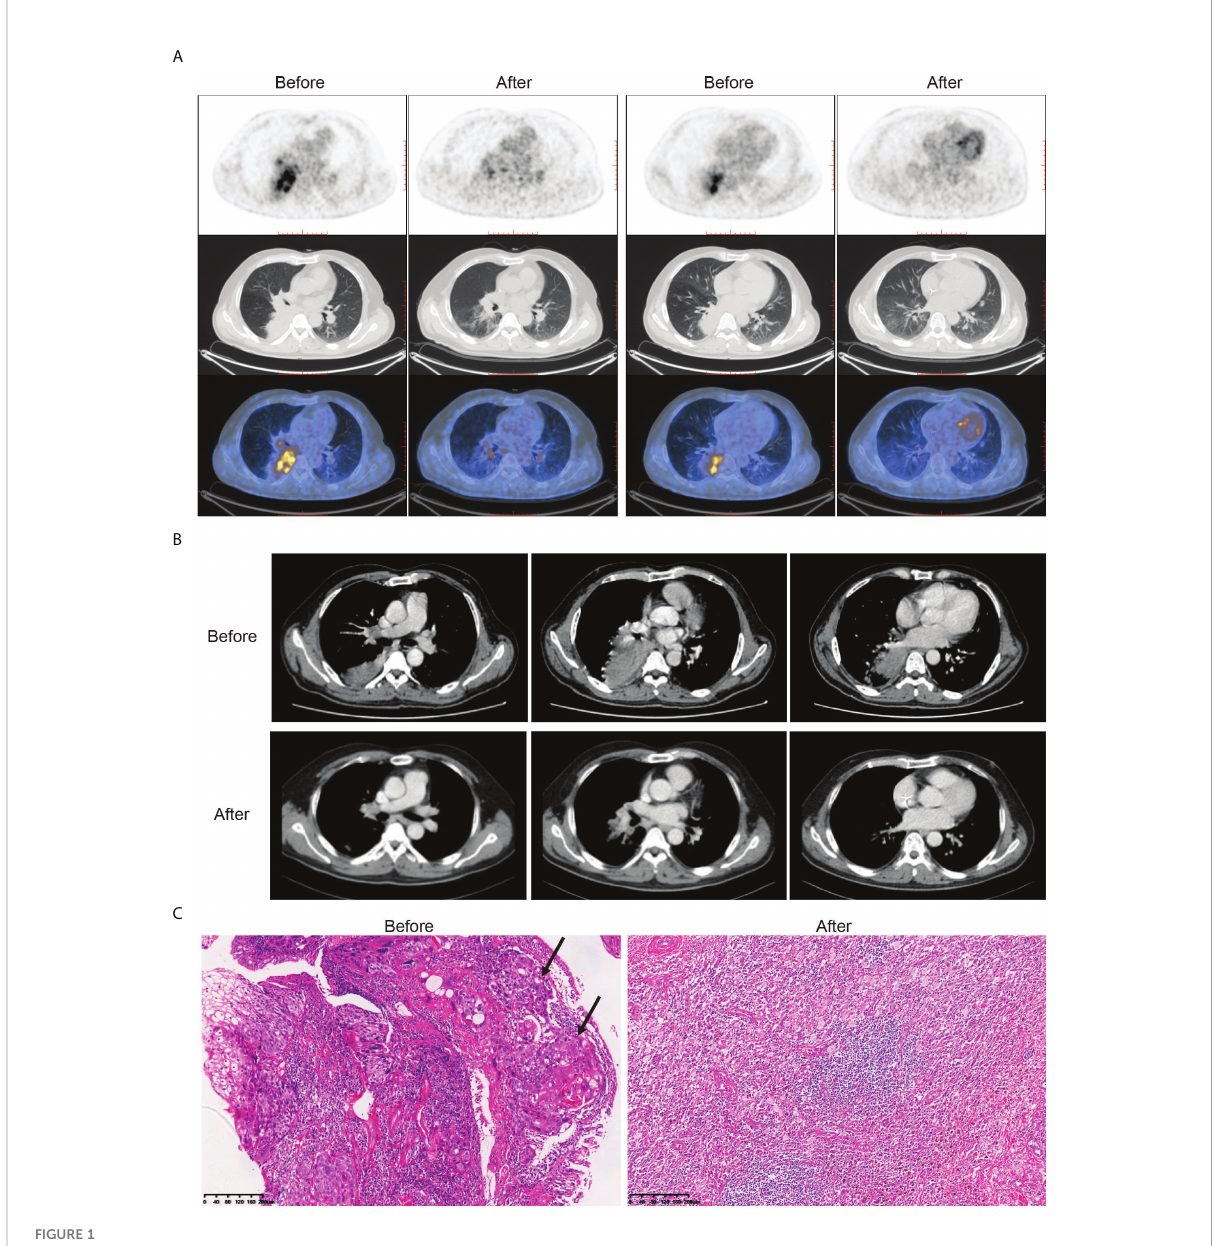
FIGURE 1 Radiological fi ndings, and histological images in one patient (case 7) with stage III NSCLC who underwent robotic-assisted thoracic surgery following neoadjuvant chemoimmunotherapy. Case 7 had a pathological complete response to neoadjuvant chemoimmunotherapy. (A) Representative (18)F- fl uorodeoxyglucose positron emission tomography/computed tomography before and after neoadjuvant chemoimmunotherapy. (B) Representative chest computed tomography imaging before and after neoadjuvant chemoimmunotherapy. (C) Histological examinations of pretreatment tumor biopsy and posttreatment resected tumor specimen by hematoxylin and eosin staining. Poorly differentiated tumor cells (black arrow) were observed before neoadjuvant chemoimmunotherapy, which was replaced by fi brotic, elastostatic, and necrotic tissue mixed with in fl ammatory cell in fi ltration afterward. Scale bar = 200 m